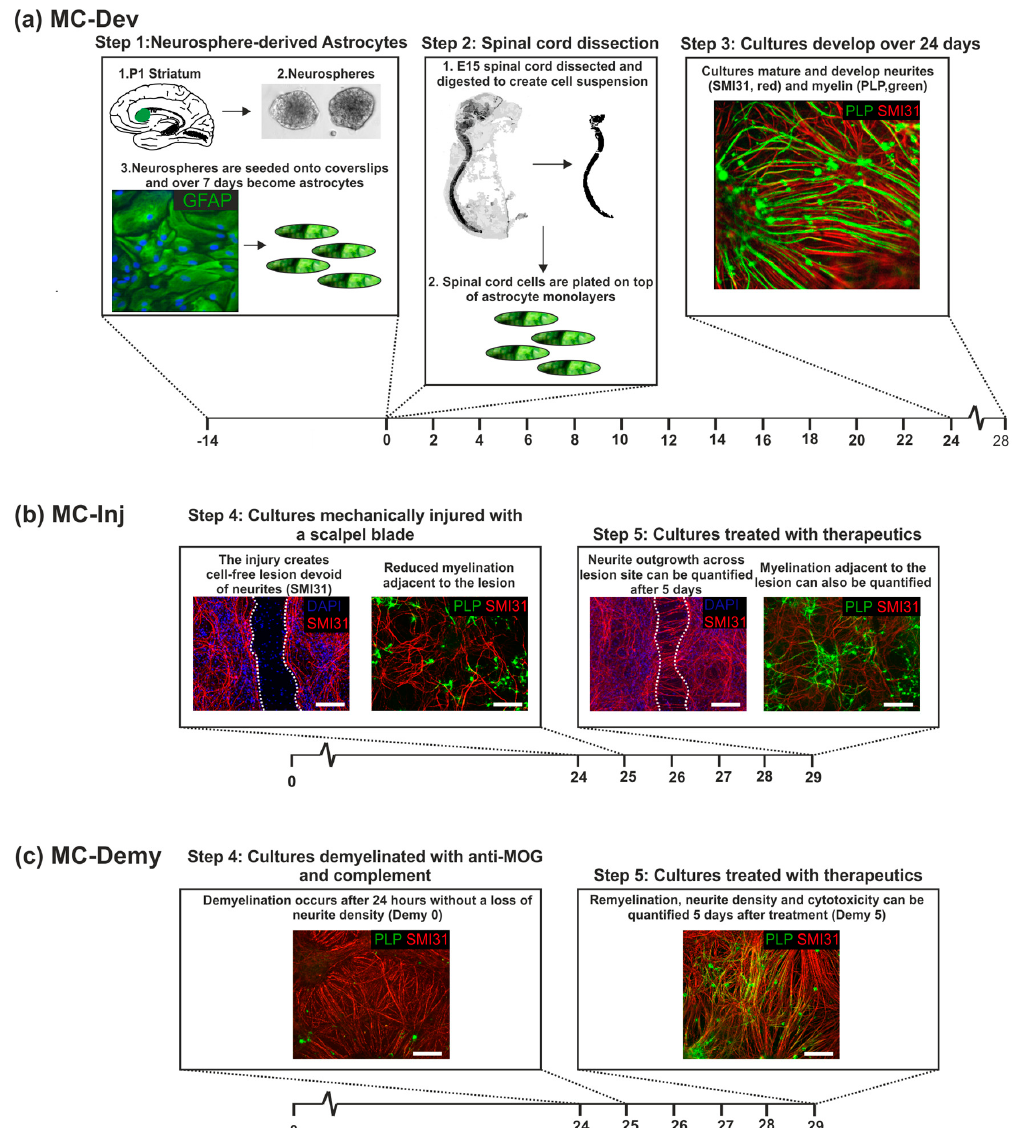
Figure 1. Schematic of in vitro myelinating cultures MC-Dev, MC-Inj, and MC-Demy. ( a ) MC-Dev are set up using astrocytes derived from neurospheres (Step 1, GFAP stains astrocytes in green) and mixed spinal cord cells derived from embryos at day 15 (Step 2) and allowed to develop for at least 24 days (Step 3). Therapeutics can be introduced from when the process of myelination begins (day 12–16) to determine their e ff ect on de novo myelination. ( b ) The cultures can be used to mimic CNS injury (MC-Inj) by cutting with an 11mm single edge razor blade pressed gently across the center of the coverslip on day 24 (Step 4). The day after injury, cultures can be treated with therapeutics and the extent of neurite outgrowth (SMI31 stains axons in red, DAPI stains nuclei blue) or myelination (PLP stains myelin in green) adjacent to the injury site quantified (Step 5). Dotted white line demarcates injury site. ( c ) To study remyelination, the cultures are demyelinated by overnight incubation with the Z2 antibody that recognizes myelin oligodendrocyte glycoprotein (MOG) and rabbit complement at 37 ◦ C (Step 4). The day after demyelination the cultures can be treated with therapeutics and after 5 days the levels of remyelination quantified compared to non-treated control cultures (Step 5). Scale bars represents 100 µ